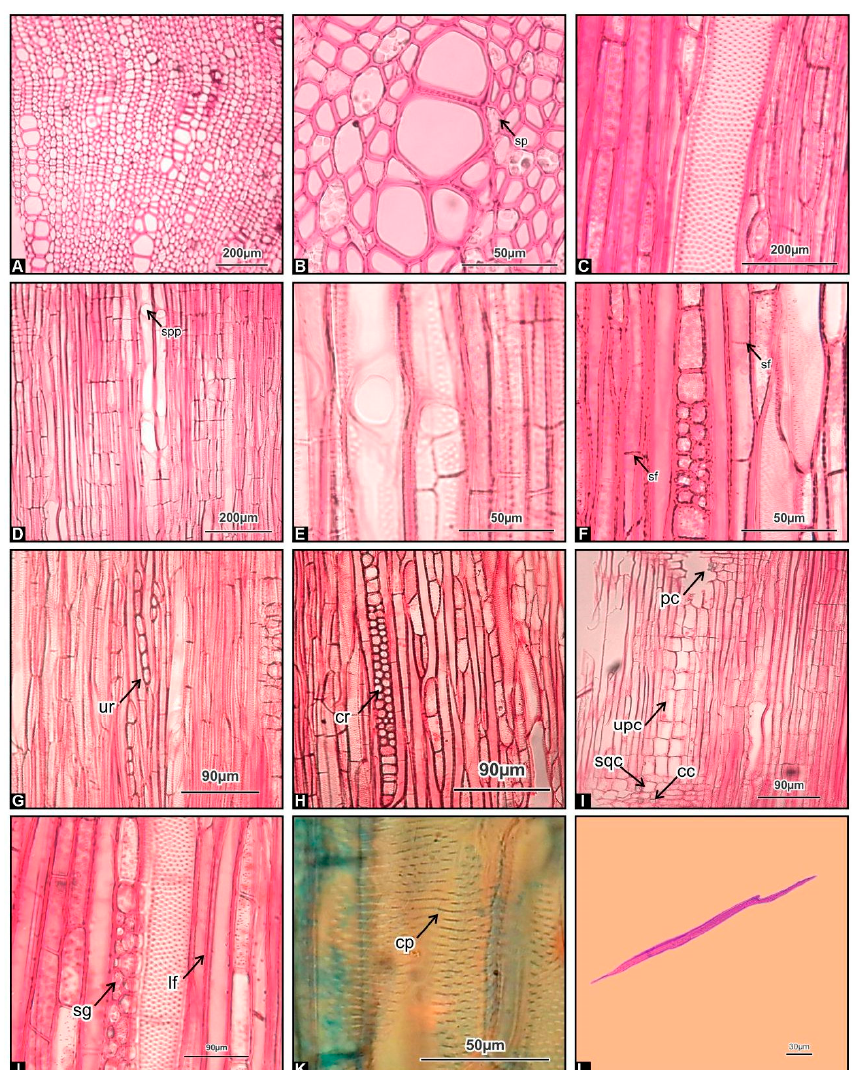
Figure 3. Wood anatomy of Kopsia fruticosa Roxb. root: ( A ) TS revealing a radial arrangement of vessels; ( B ) magnified portion showing scanty paratracheal parenchyma; ( C ) image showing alternate vestured pits; ( D ) RLS revealing simple perforation plate; ( E ) magnified portion of simple perforation plate; ( F ) image showing septate fibres; ( G ) TLS image of uniseriate rays; ( H ) section showing compound rays; ( I ) section showing upright, square, and procumbent cells with rhomboidal calcium oxalate crystals; ( J ) section showing rays with starch grains and libriform fibres; ( K ) magnified portion showing coalescent pits in vessels; ( L ) a libriform fibre; sp—scanty paratracheal parenchyma; spp—simple perforation plate; sf—septate fibre; ur—uniseriate rays; cr—compound rays; upc—upright cell; sqc—square cell; pc—procumbent cell; sg—starch grain; lf—libriform fibre; cc—chambered crystal; cp—coalescent pits.